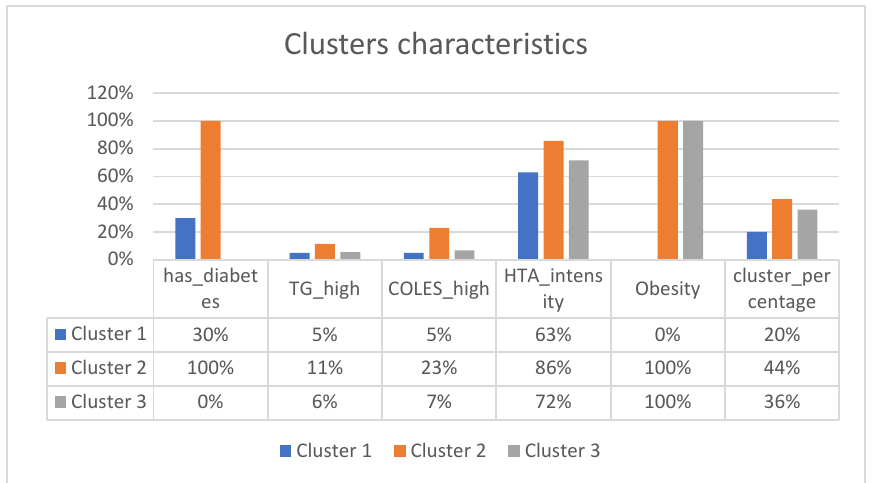
Figure 5. Number of observations for each cluster.